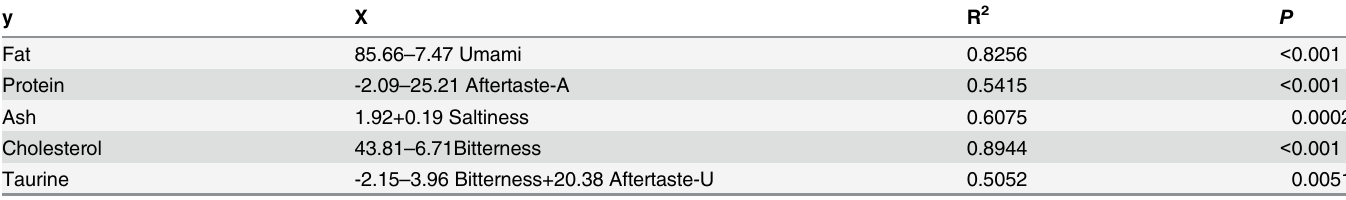
Table 3. The regression formula between chemical composition and flavor.